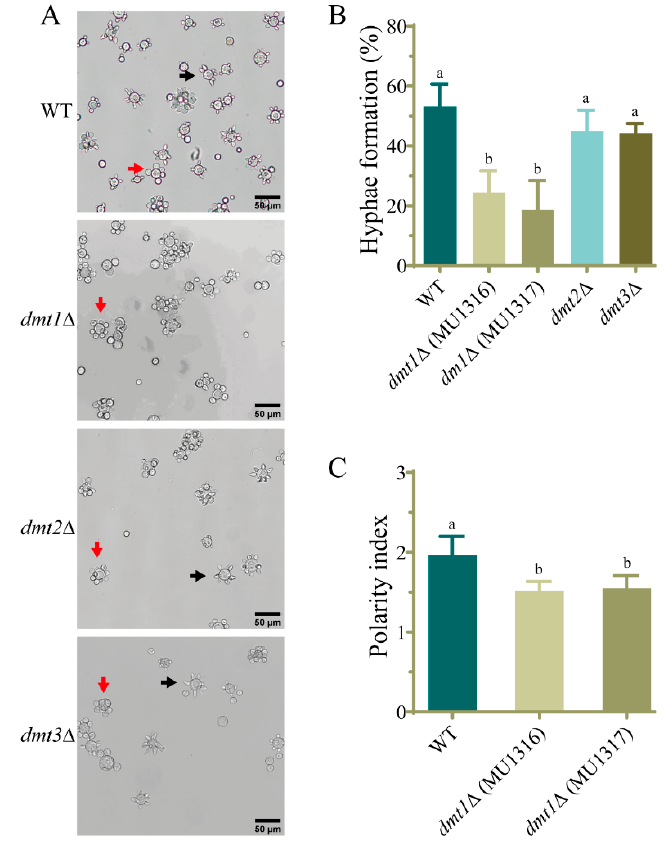
Figure 1. The mutants in the dmt1 gene of M. lusitanicus are affected in the hyphae emergence during yeast to mycelium transition. ( A ) Cells of wild-type strain MU636 (WT), dmt1 Δ (MU1316 and MU1317), dmt2 Δ (MU1318), and dmt3 Δ (MU1320) 2.5 h after induction of hyphal development by transferring to aerobic conditions. The arrows indicate the multi-budded yeasts (red) and cells with hyphae (black). ( B ) The data represent the percentage of hyphae formation 2.5 h after transition induction calculated from 200 total cells. ( C ) Polarity index quantified from 50 yeasts with hyphae emergency after 2.5 h induction. The charts display means ± SD. Different letters above the bars indicate statistically significant differences, while the identical letters denote no significant differences calculated using one-way ANOVA ( p < 0.001, Tukey test). Three independent experiments were conducted for each strain.